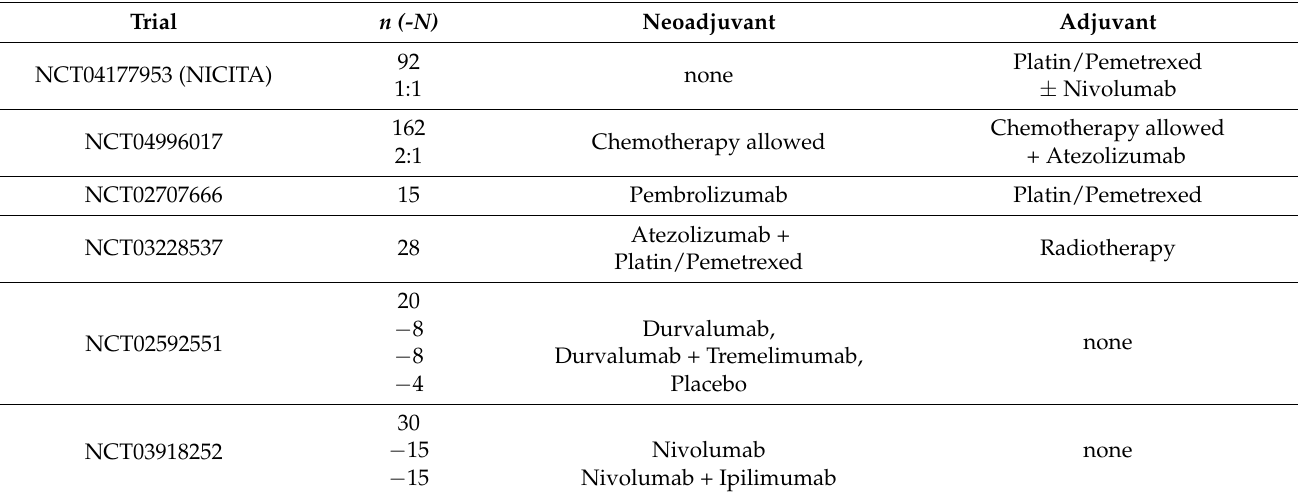
Table 3. Selected trials with multimodal treatment and immune checkpoint inhibitors at an early